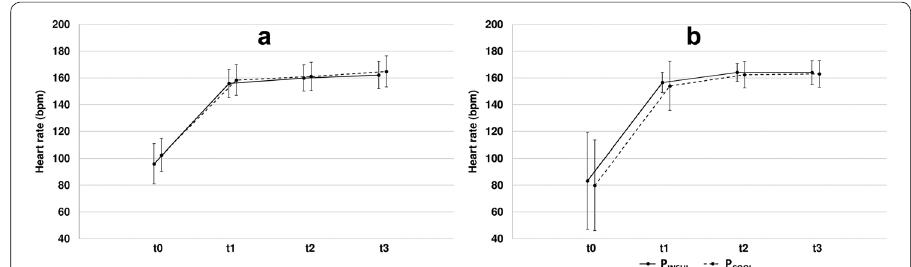
Fig. 6 Heart rate as measured after warm-up (t0) and after 15 min (t1), 30 min (t2) and 45 min (t3) of running for the thermally insulating (P INSUL ) and non-insulating (P COOL ) pants in studies A ( a ) and B ( b ). No significant differences were found between P INSUL and P COOL but factor time was significant in study A and B (p < 0.05)